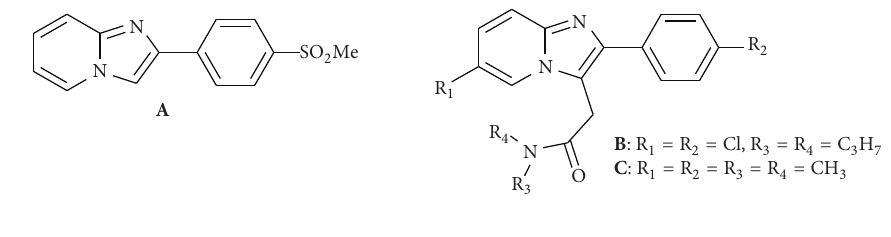
F 1: Examples of well-known drugs containing imidazo